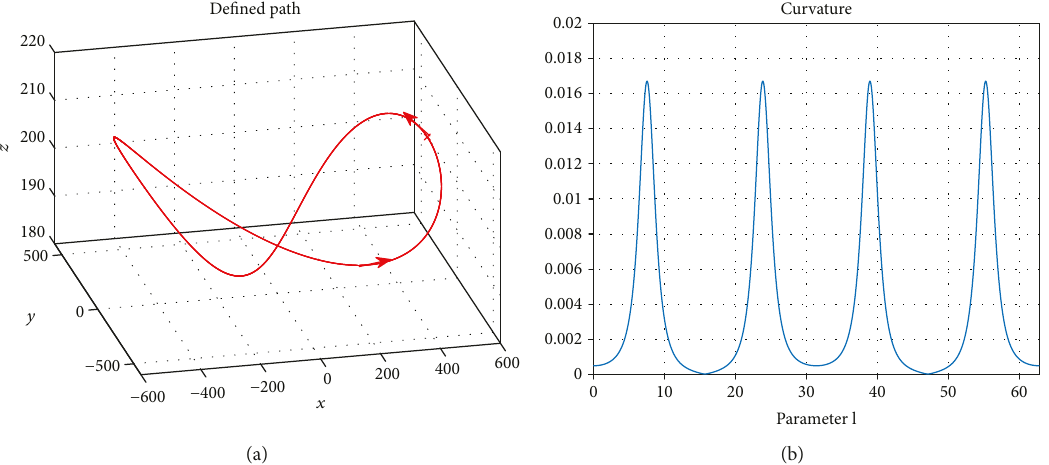
Figure 11: De fi ned path. (a) Three-dimensional view and (b) curvature.